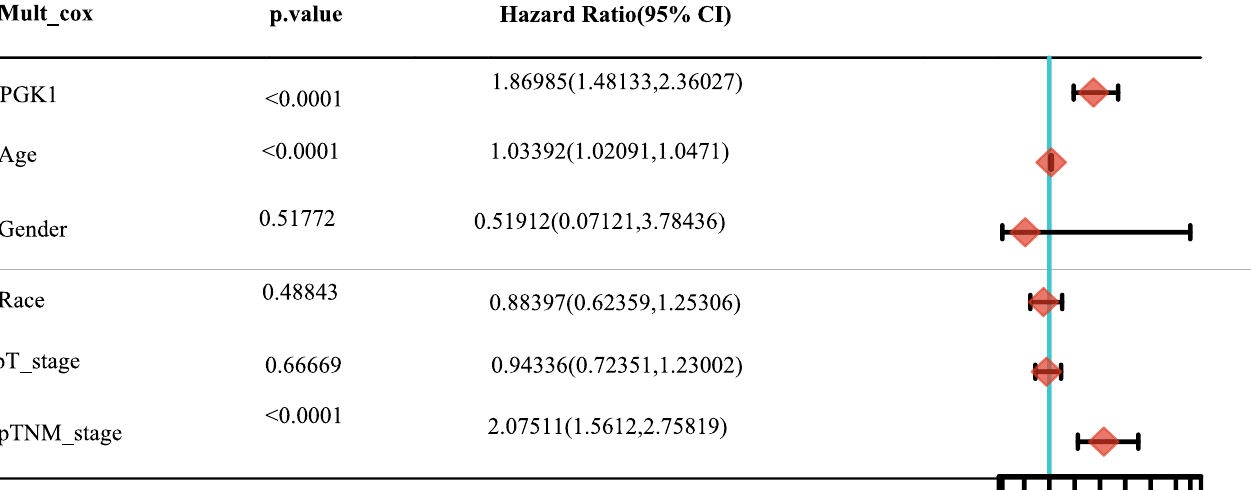
TABLE 7 | Hazard ratio and p -value of constituents involved in multivariate Cox regression and some parameters of the PGK1 gene.